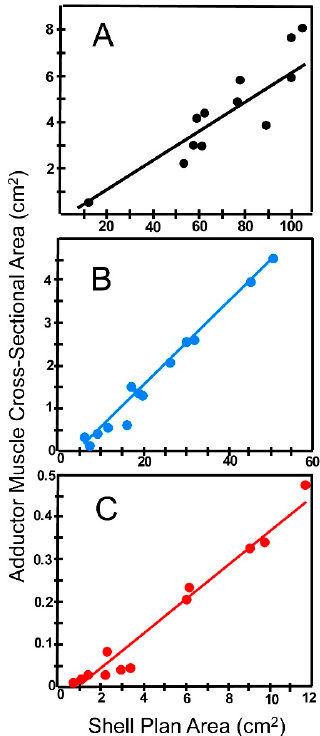
Figure 12. Sum of the cross-sectional area of the anterior and posterior muscle scars regressed as a function of plan area of the shell (plan area is the area of a flat surface defined by the periphery of the shell). Specimens selected randomly from among our total collection. ( A ) Pyganodon cataracta; ( B ) Elliptio complanata ; ( C ) Corbicula fluminea . Note that three the graphs have different units on the X and Y axes. Regression parameters: P. cataracta : Y = 0.076X − 0.906; R = 0.906. E. complanata : Y = 0.101X − 0.485; R = 0.993. C. fluminea : Y = 0.043X − 0.030; R = 0.982. Table 6. Escape from anastrophic burial as a function of shell size, burial depth, and sediment grain size for Pyganodon cataracta and Elliptio complanata . L—Shell length in cm. σ —standard deviation. Grain size; Coarse—0 Φ to1 Φ ; Fine—2 Φ to 3 Φ . Total data set—results for all tests conducted from 1 to 10 cm burial depth. Shallow Burial—results for tests conducted only from 1 to 5 cm burial depth. Deep Burial—results for tests conducted only from 6 to 10 cm burial